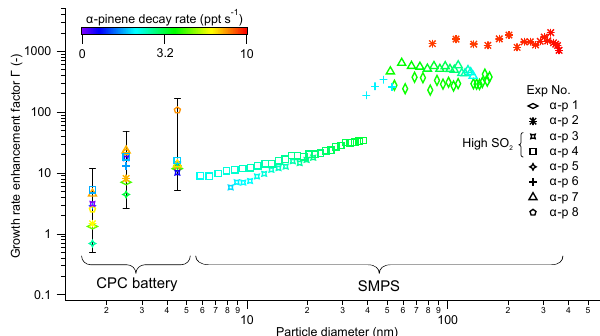
Fig. 6. Growth rate enhancement factors 0 as a function of diameter from CPC battery and SMPS data. Different markers correspond to different experiments, color coded with the decay rate of α -pinene. Note that the experiments α -p 3 and α -p 4 were performed with in- jection of 5ppbv of SO 2 producing a higher sulfuric acid concentra- tion compared to the other experiments, hence influencing the cor- responding 0 results. 0 values were not available from the SMPS measurements during two experiments, α -p 5 and α -p 8, because of the poor quality of the SMPS data during these experiments.